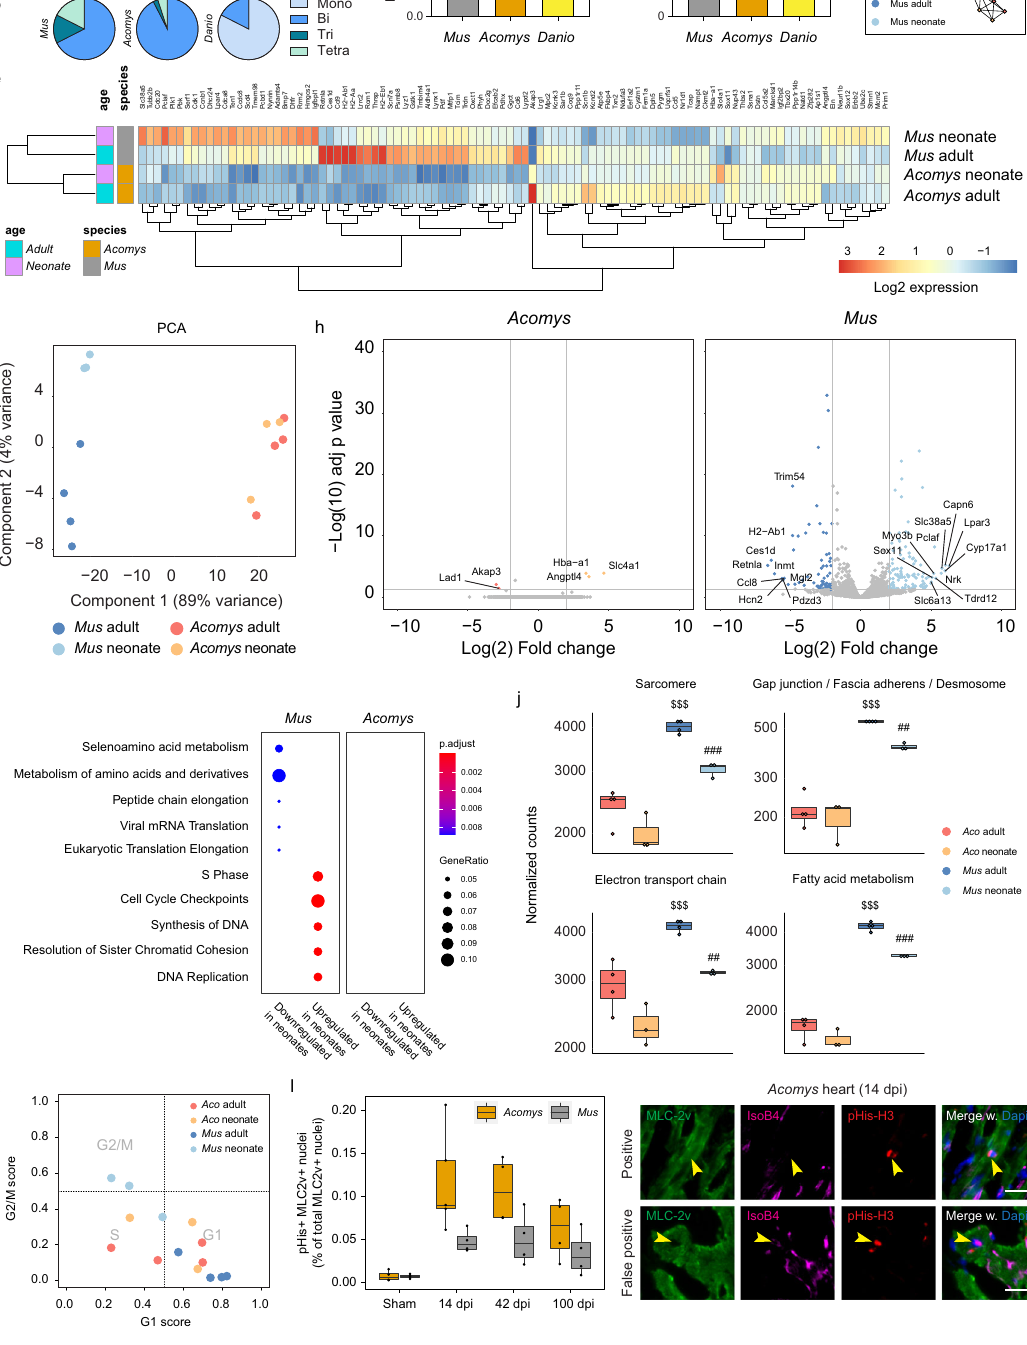
The epicardium is critical for coronary vasculature development during mammalian embryogenesis and during adult zebra fi sh heart regeneration 25 . Using scanning electron microscopy on scarred and sham-operated tissues, we imaged the epicardial surface across different time points post-MI. In